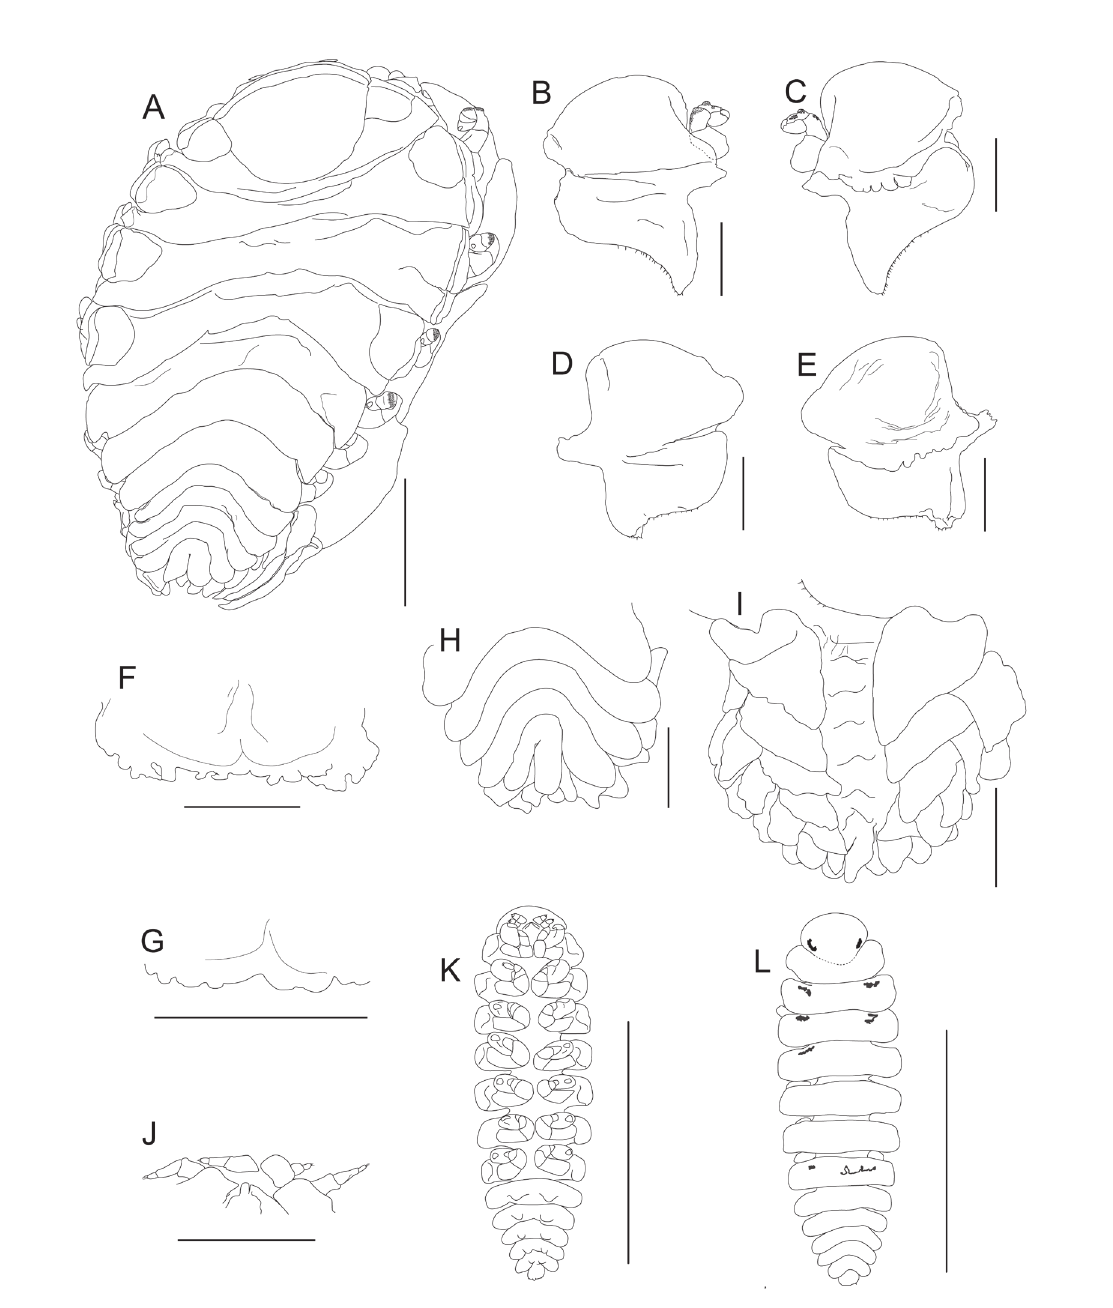
Fig. 9. Bopyrissa wolffi Markham, 1978. A . Ovigerous ♀, dorsal view, (CNCR-36503-D). B . First oostegite left side, external view. C . Same, internal view. D . First oostegite right side, external view. E . Same, internal view. F . Barbula. G . Barbula (CNCR-36501). H . Pleon, dorsal view (CNCR-36501). I . Pleon, ventral view. J . Antennule and antennae. K . ♂, ventral view. L . Same, dorsal view. Scale bars: A, K–L = 1.0 mm; B–G, I–J = 0.5 mm; H = 0.2